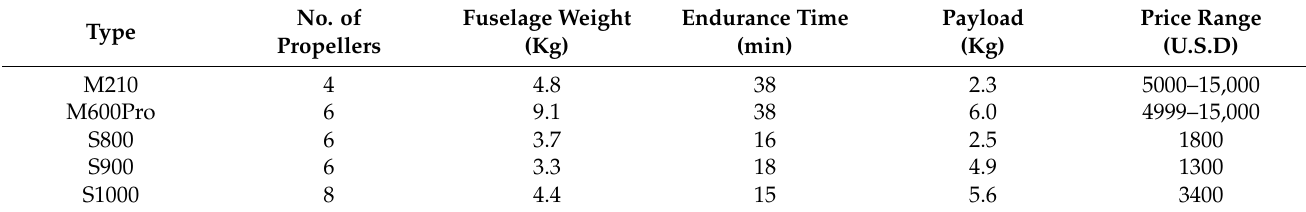
Table 2. Comparison of small multirotor UAVs (<15 kg) of the DJI